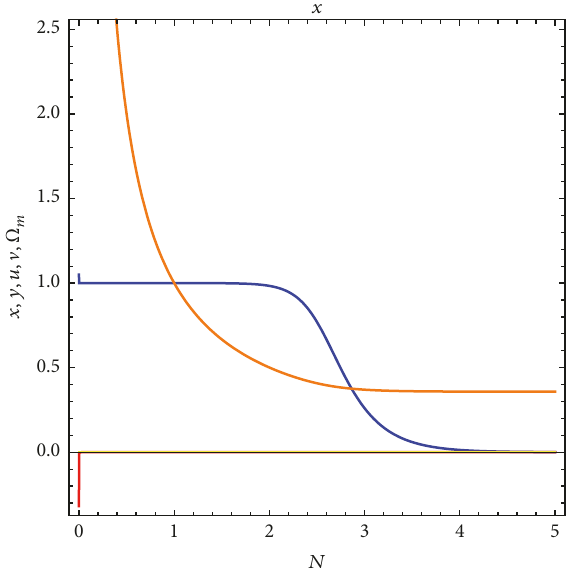
Figure 15: Plot of ( 15 ) variations of 𝑥 (blue), 𝑦 (green), 𝑢 (orange), V (red), and Ω 𝑁 near 𝑃 𝛾 = 1 , 𝛿 = 1/(4√6) , Figure 13: Plot of (13 ) variations of 𝑥 (blue), 𝑦 (green), 𝑢 (orange), 푚 (yellow) versus 16 , for V (red), and Ω 𝑁 near 𝑃 𝛾 = 1 , 𝛿 = 1 , and and 𝜆 = −0.5 . The position corresponding to 𝑁 = 0 is the fixed point 푚 (yellow) versus 14 , for 𝜆 = −0.5 . The position corresponding to 𝑁 = 0 is the fixed point under under consideration.